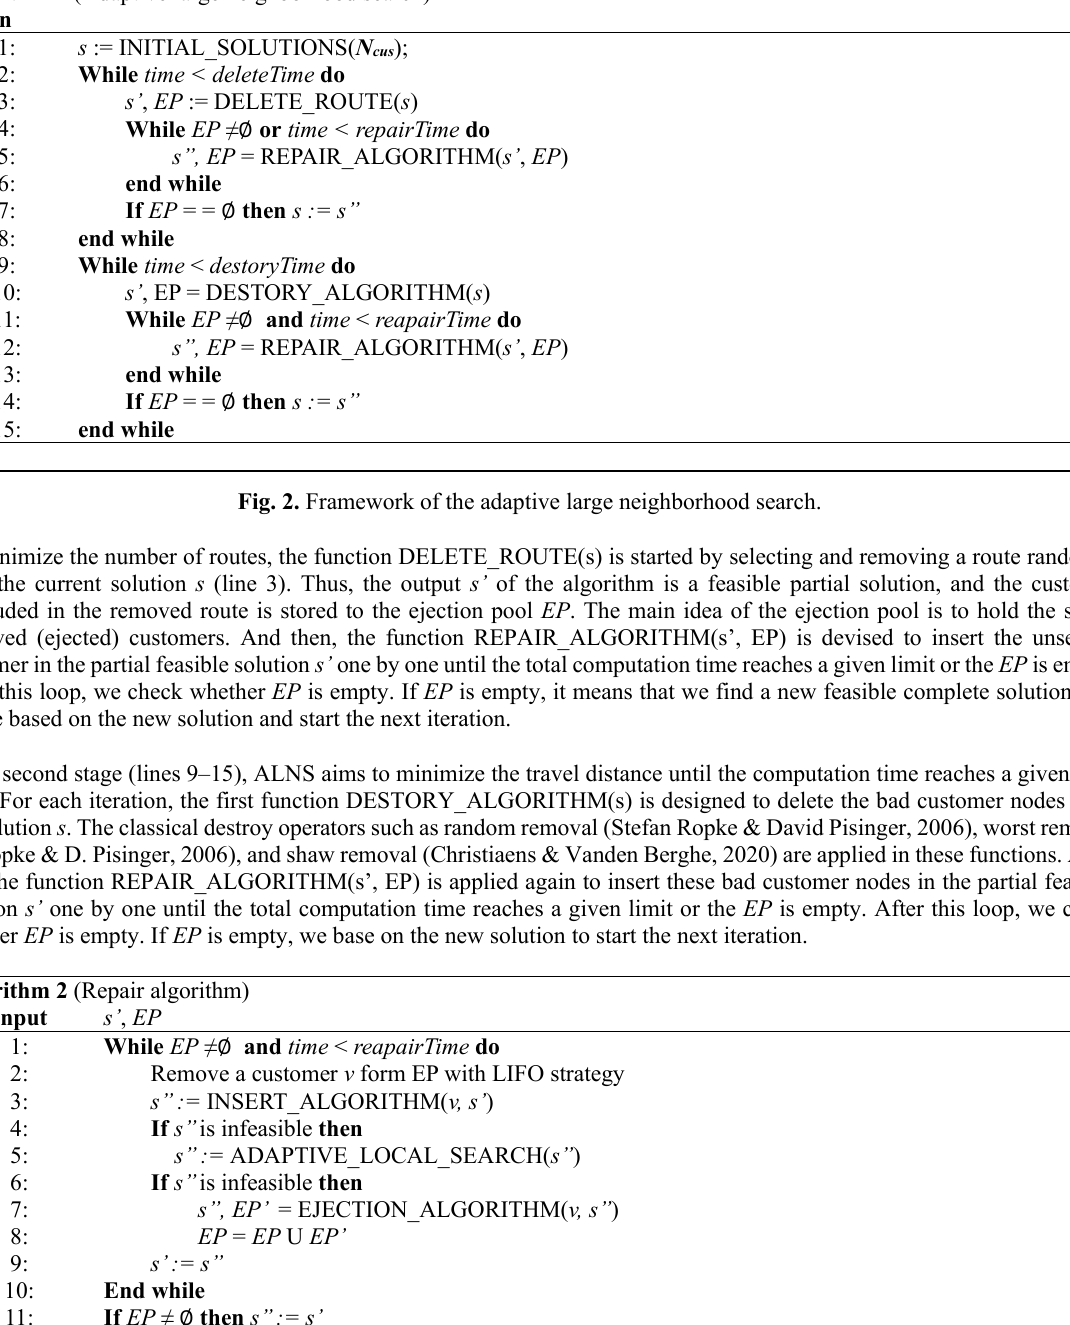
Fig. 3. The framework of the repair